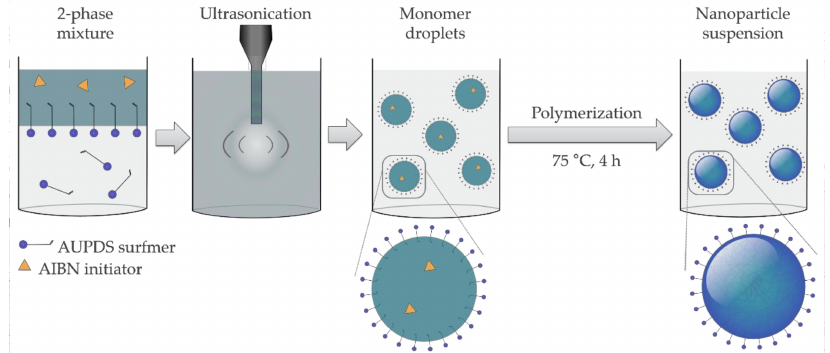
Figure 1. Schematic representation of the direct mini-emulsion polymerization process with AUPDS surfmer. The reaction mixture is composed of a continuous phase (AUPDS dissolved in water) and a dispersed phase (MMA or St, cross-linker, AIBN, and hexadecane). This mixture is (mini)emulsified using probe ultrasonication, to form critically stable monomer droplets, which are then polymerized. Nucleation occurs predominantly in the monomer droplets and this allows for the production of particles that are a 1:1 copy of the droplets prior to polymerization. Objects shown are not drawn to